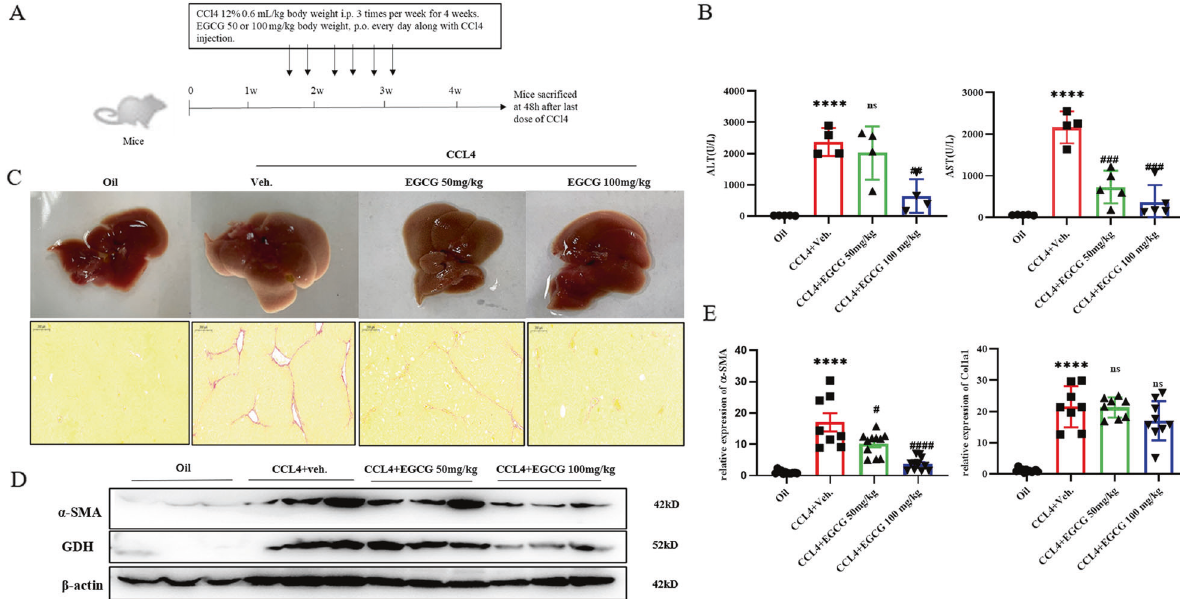
Fig. 3 Glutaminolysis activates myo fi broblastic HSCs in chronically injured fi brotic livers in mice. A Animal experimental procedures. B ALT and AST levels in serum. C Representative pictures of liver morphology in each group at sacri fi ce and Sirius red staining (scale bars = 200 μ m); red indicates fi brosis. D Western blot analysis of the protein expression of α ‐ SMA, Col1a1, GDH and SIRT4. E Real ‐ time quantitative PCR analysis of the mRNA expression of fi brotic genes. The data are reported as the mean ±SD. * p < 0.05; ** p <0.01; *** p < 0.001; **** p <0.0001 versus the oil group. # P <0.05, ## P <0.01, and ### P <0.001 versus the CCL4 + Veh